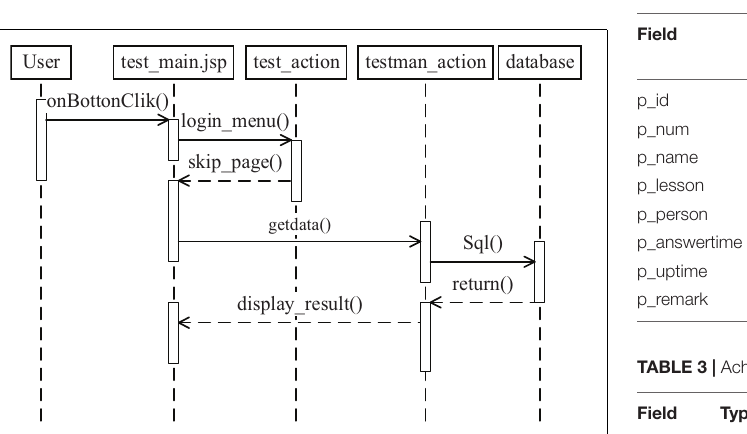
TABLE 2 | Test paper information table.